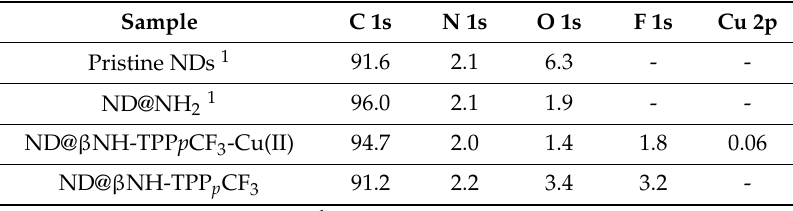
Table 1. Surface atomic percentages of the elements for pristine ND, ND@NH 2 , ND@ β NH-TPP p CF 3 - Cu(II) and ND@ β NH-TPP p CF 3 obtained from XPS.